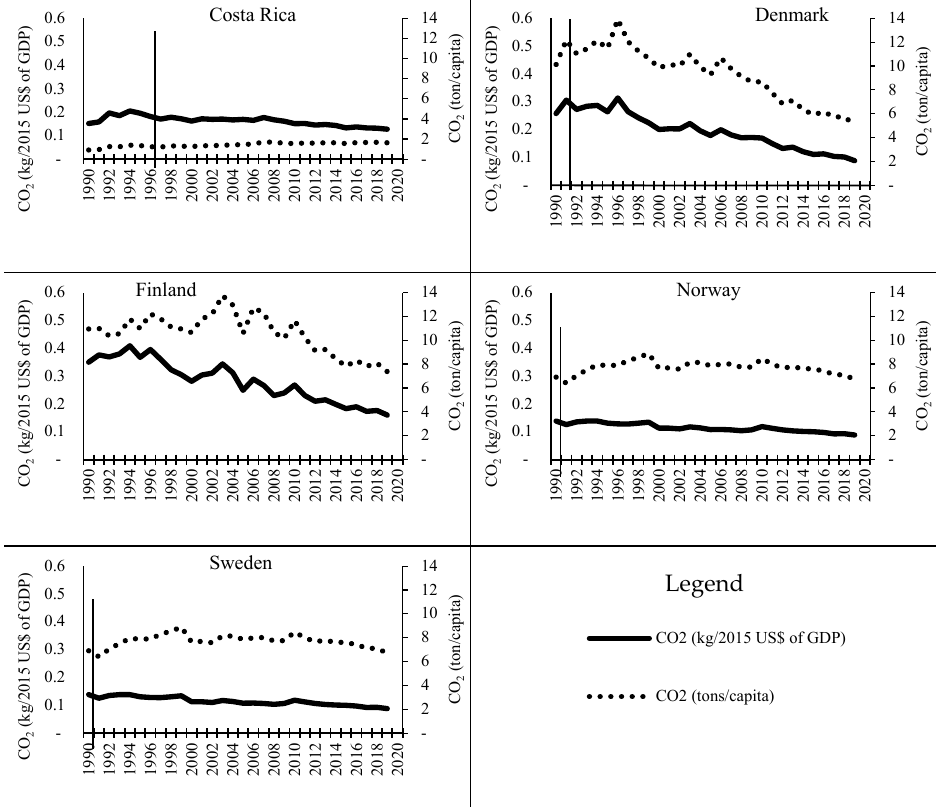
Figure 2. The effects of a carbon tax on the respective country, which had a carbon tax for over ten years (Source: self-representation of the data from the World Bank).